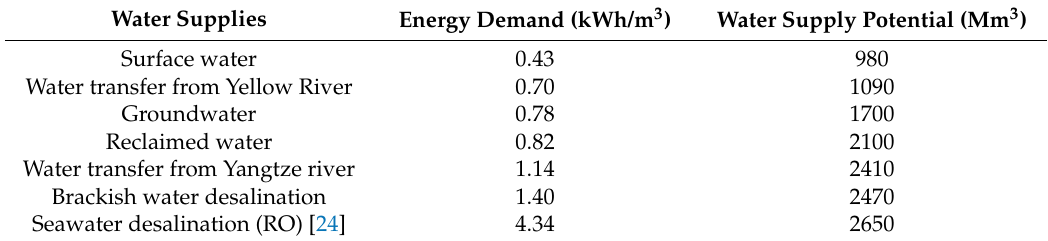
Table 5. Energy demand and water supply potentials of water supply alternatives (from